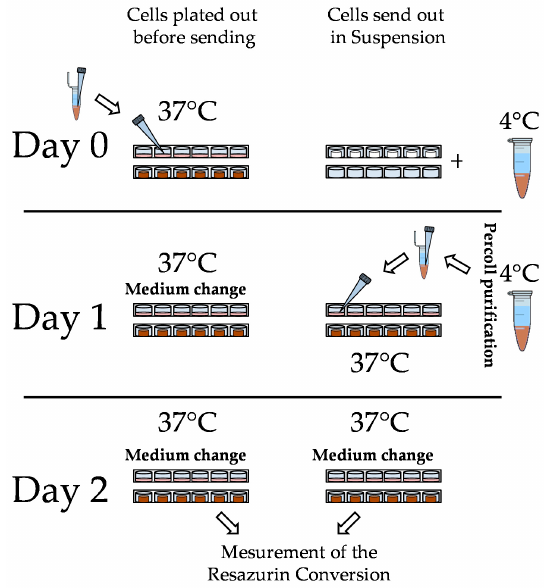
Figure 1. Schematic illustration of the transport schemes: on day 1, the primary human hepatocytes (PHHs) were purified and sent either in suspension or directly plated onto 2D culture plates and Optimaix-3D scaffold. Then, cells were sent at 37 °C (plated cells) or at 4 °C (cells in suspension) overnight. On day 1, the medium was changed in the plated cultures, while the cells in suspension were purified and plated out (2D, Optimaix-3D scaffold). Two days after isolation, a viability determination of all conditions was carried out by measuring resazurin conversion.